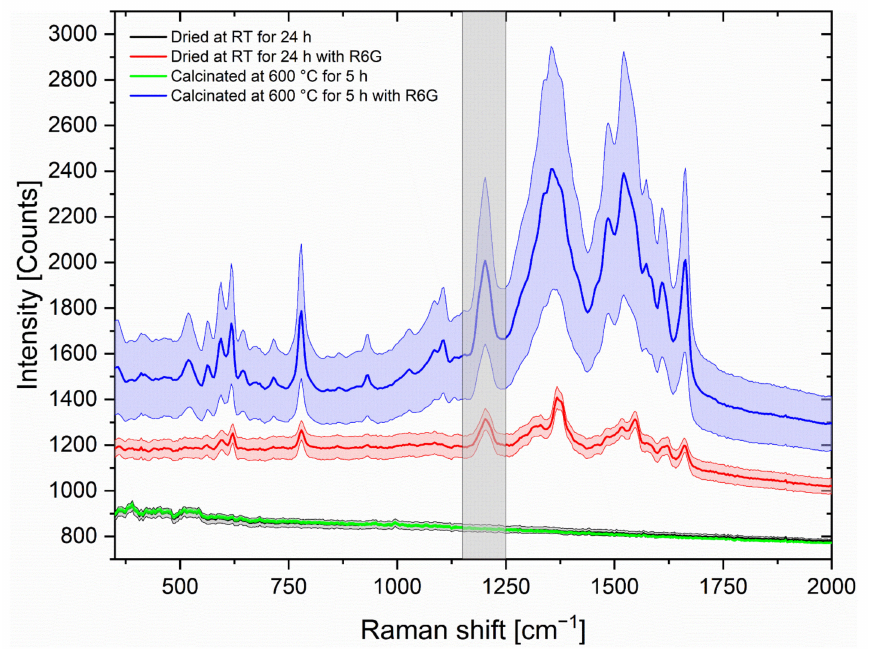
Figure 6. Mean SERS spectra as well as the standard deviations of a 3 to 3 mappings with the 638 nm Laser with 35 mW, 1 s integration time and 10 spectra each mapping position of the SERS-substrates with a TTIP coating dried for 24 h under ambient conditions and 5 h at 600 ◦ C, followed by coating with the AuNPs suspension with and without R6G (conc. 10 − 6 mol/L)